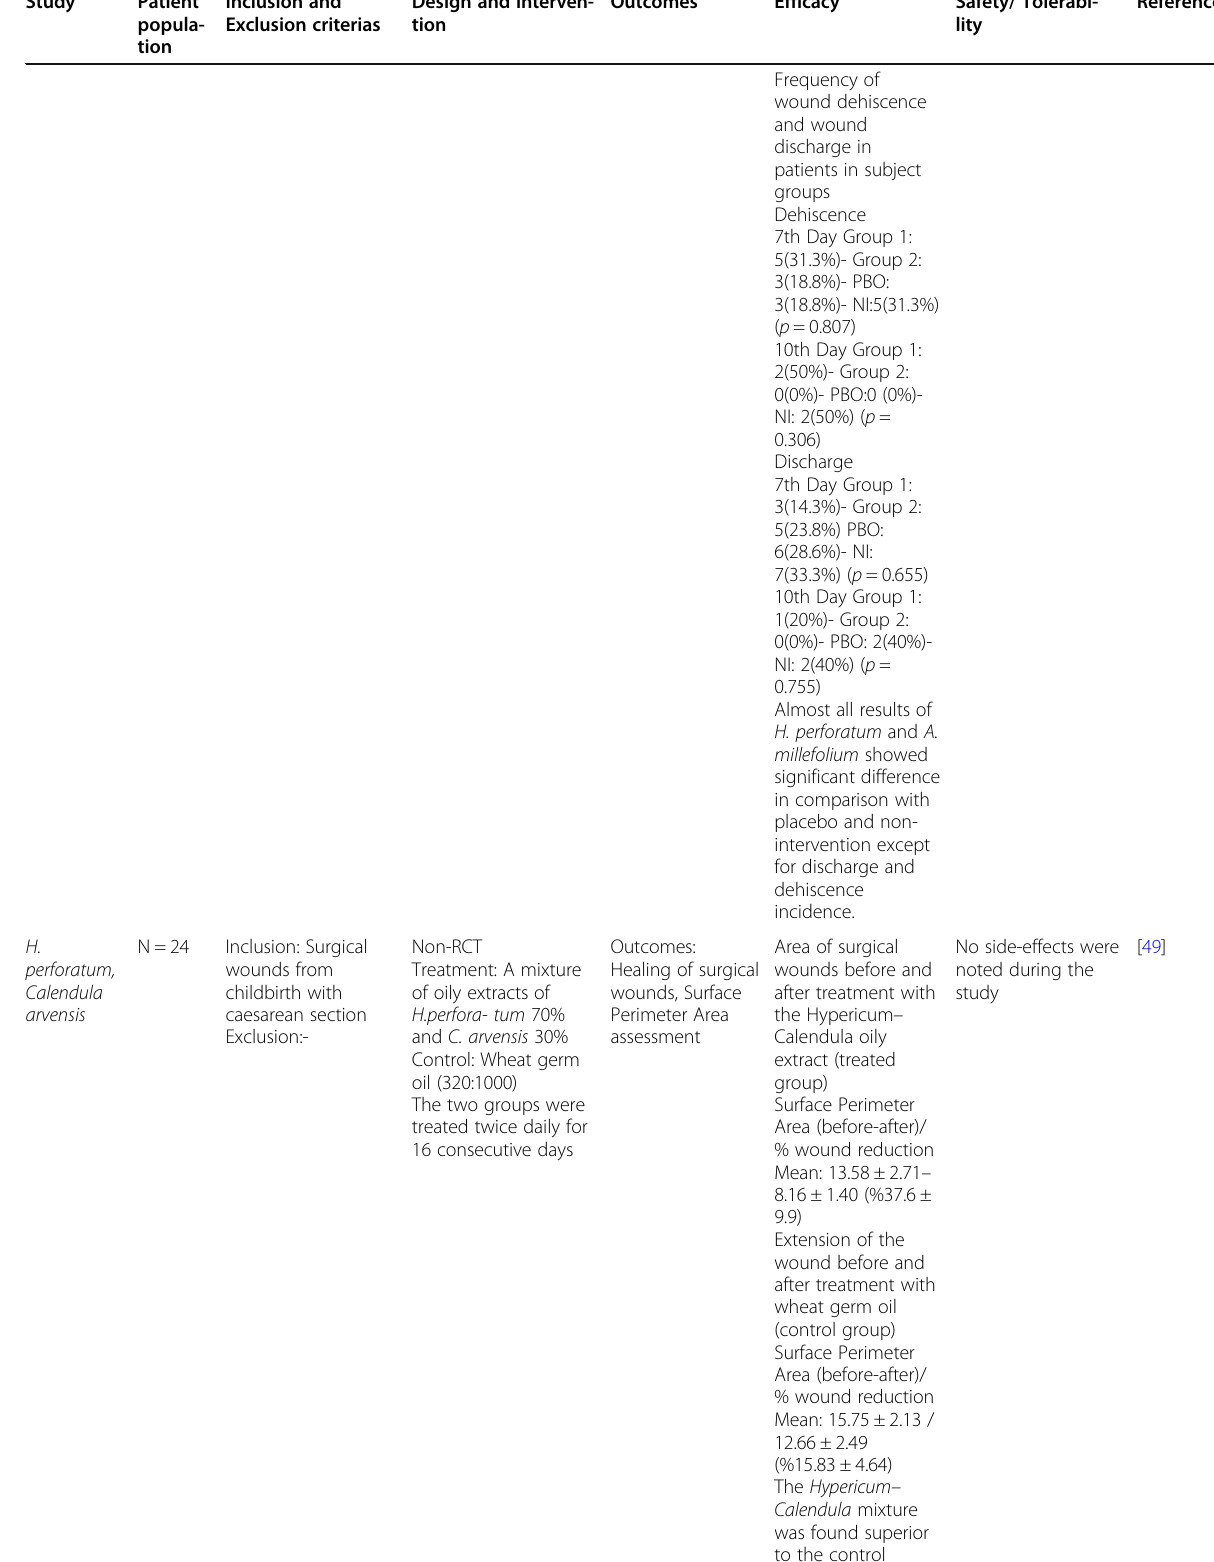
Table 4 Clinical trials of the traditional plants used for skin problems in Turkey (Continued) Study Patient